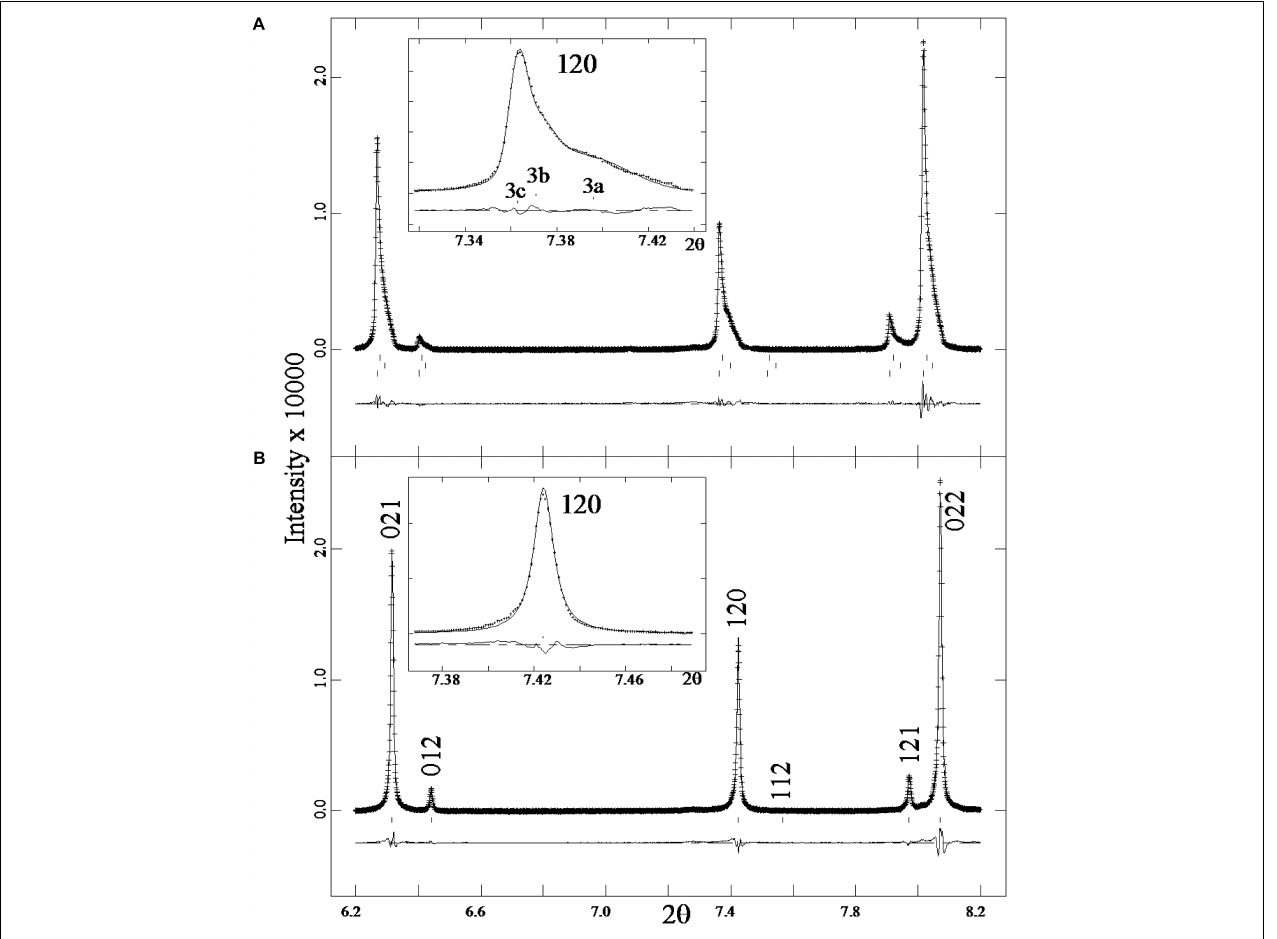
FIGURE 4 | Expanded views of a small 2 θ range from the HRPXRD traces for (A) sample 3 and (B) sample 2. The diffraction peaks are symmetrical in (B) compared to the asymmetrical peaks in (A) that contain a three-phase intergrowth of nepheline. These features are shown more clearly in the inserts for the 120 peak. The three phases (3a, 3b, 3c) are labelled in (A) and they give rise to a “triplet” of splitting or “humps” in each diffraction